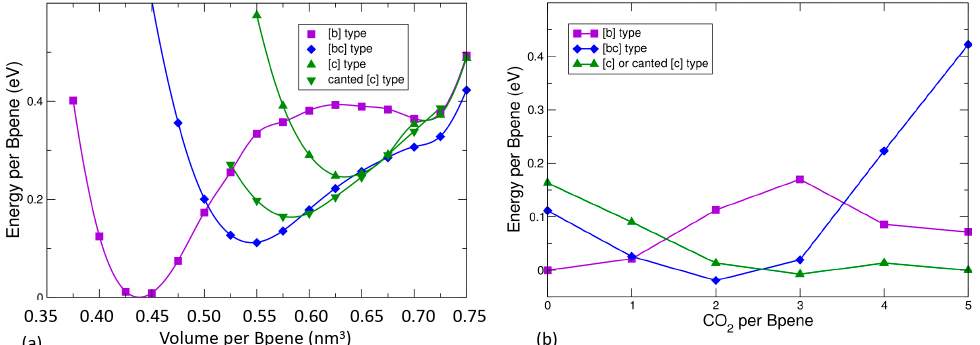
Figure 7. ( a ) Predicted DFT energy versus volume for empty NiBpene for various Bpene orientational patterns; ( b ) predicted DFT relative energy per Bpene for different types of Bpene orientational patterns and different CO 2 loadings. The effective chemical potential is set so that the minimum energy is zero for 0 and 5 CO 2 per Bpene.